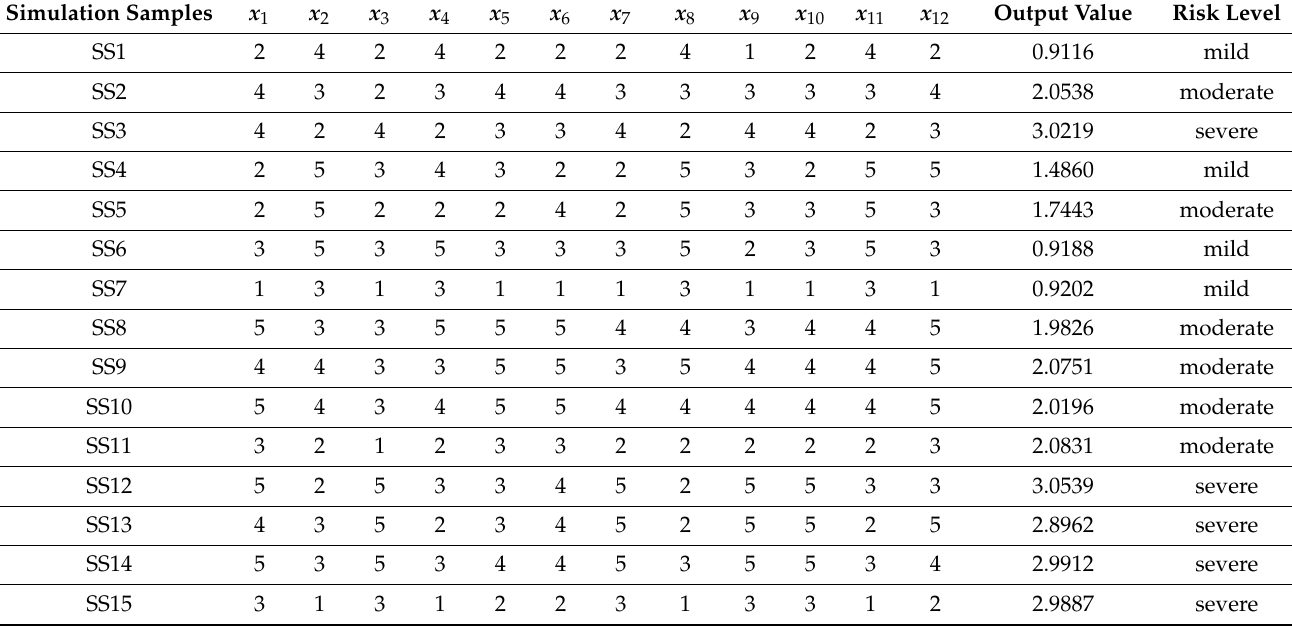
Table 5. The indicator values of the 15 simulation samples and their output values and the risk